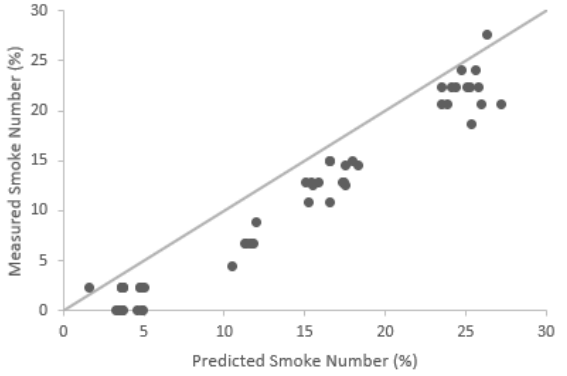
Figure 3. Correlation between measured [26] and predicted smoke number, employing the Rizk and Mongia model [17], for the Lycoming ALF